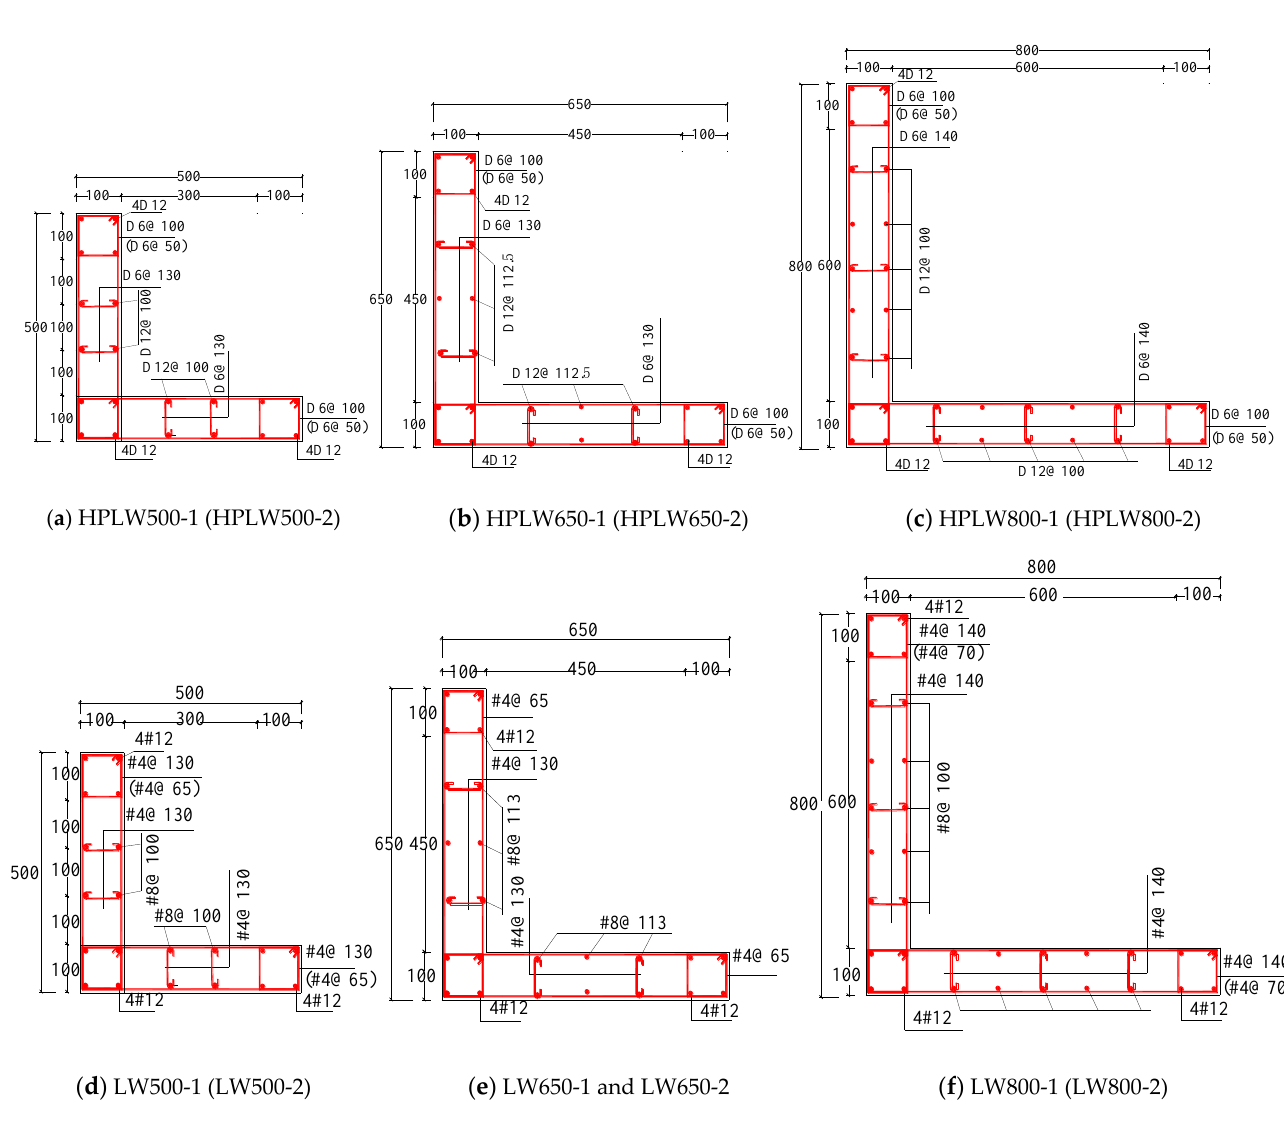
Figure 1. Dimensions and reinforcement details of HPLW and LW walls.